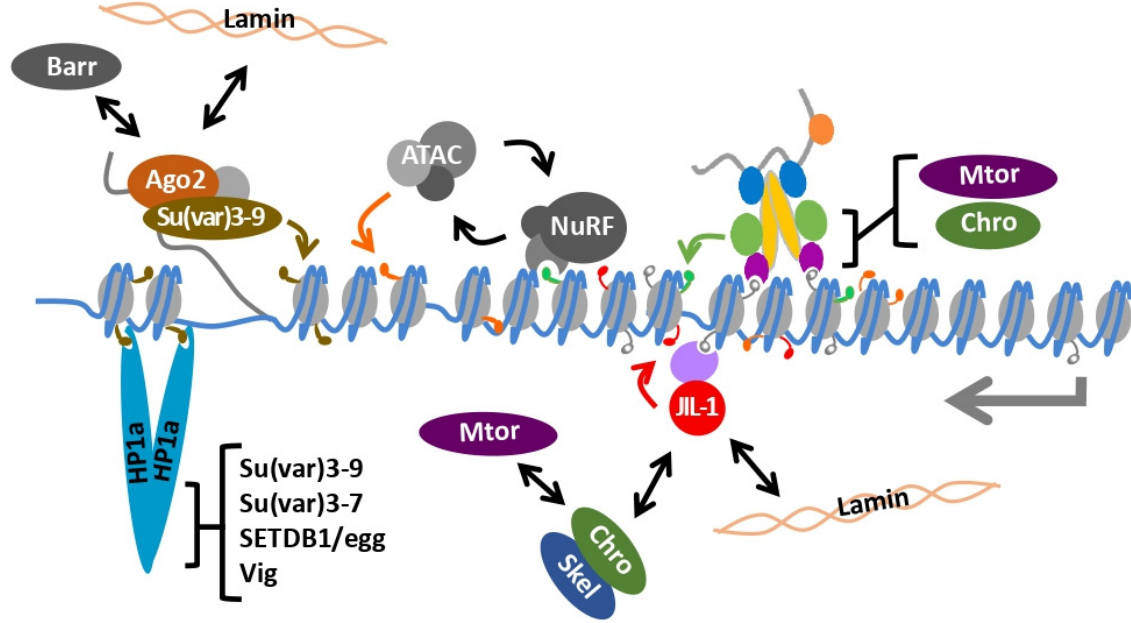
Figure 2. Genes that participate in heterochromatin formation modulate dosage compensation and X chromosome structure. ( Left ) Genes involved in heterochromatin establishment or the siRNA pathway. Ago2 recruits Su(var)3-9 to nascent transcripts in an siRNA-dependent manner, leading to enrichment of H3K9me2/3 (brown modification) and HP1a binding. Ago2 interacts with Barr, nuclear lamins and many other proteins, including HP1a. HP1a interacts with several other proteins that enhance roX1 roX2 male lethality. ( Right ) Proteins that interact with the dosage compensation machinery. Transcribed regions (gray arrow) are enriched for H3K36me3 (gray modification). Both the MSL complex ( Top ) and JASPER/JIL-1 ( Bottom ) bind H3K36me3 and are enriched in active genes. MOF acetylates H4K16 (green modifications). MOF and MSL3 interact with Chro, Mtor and several additional nuclear pore proteins (not shown). JIL-1 phosphorylates H3S10 (red modification), a mark enriched on the male X chromosome, and interacts with lamins, Chro and Skeletor. ( Middle ) H4K16ac enhances chromatin binding of the ISWI-containing NURF complex. The Gcn5-containing ATAC complex Interacts with NURF, acetylates chromatin (orange modifications) and may also modify NURF. Interactions are validated but may not be